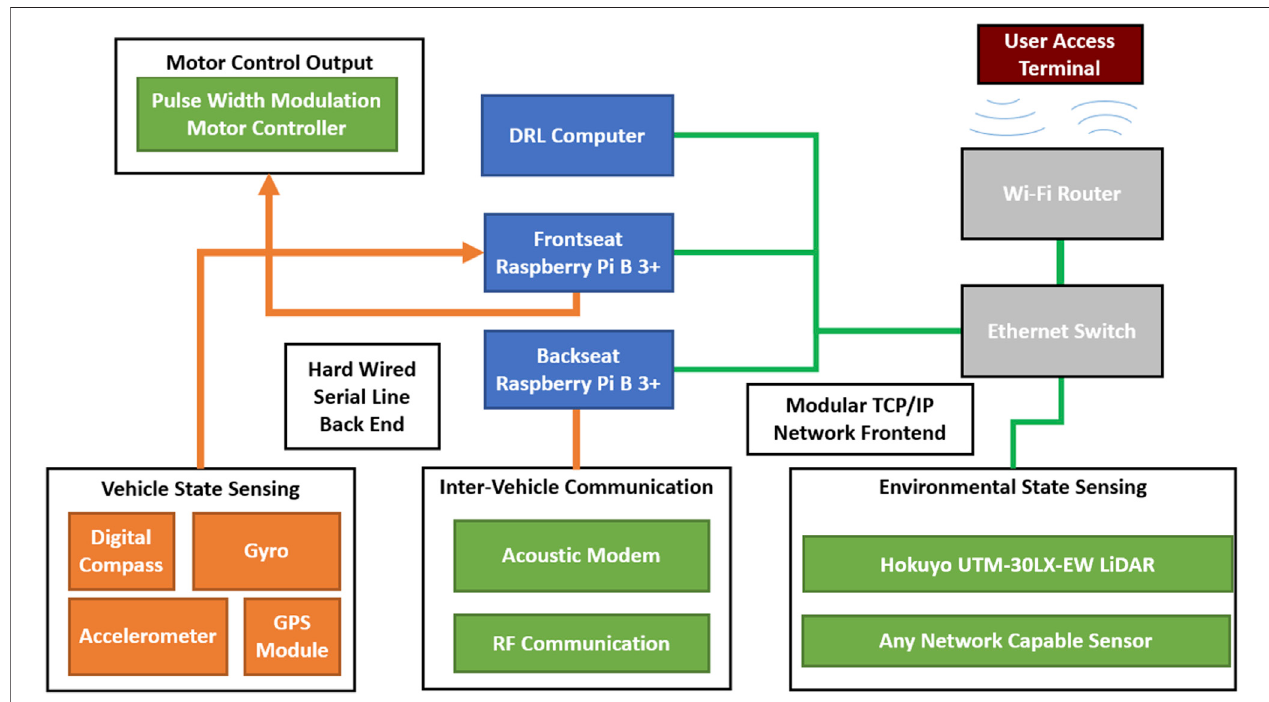
FIGURE 3 | Illustration showing components which comprise the autonomy package. Blue items comprise computational processing items, orange items comprise fi xed back-end sensors that are utilized for mid and low-level control, green items are mission speci fi c modular components that can be integrated with computational components over USB (purple lines) or ethernet (green lines), grey items represent network management items that create a local network for distributed computation and sensing.